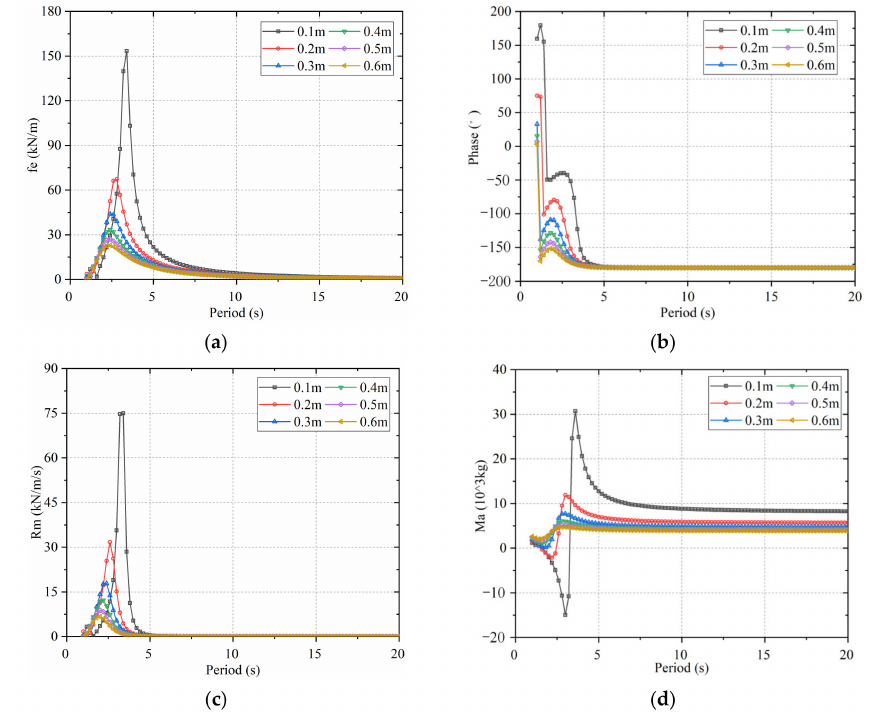
Figure 6. Hydrodynamic parameters at different submerged depths: ( a ) Wave exciting force at different submerged depths; ( b ) Phase shift wave exciting force at different submerged depths; ( c ) Radiation damping at different submerged depths; ( d ) Added mass at different submerged